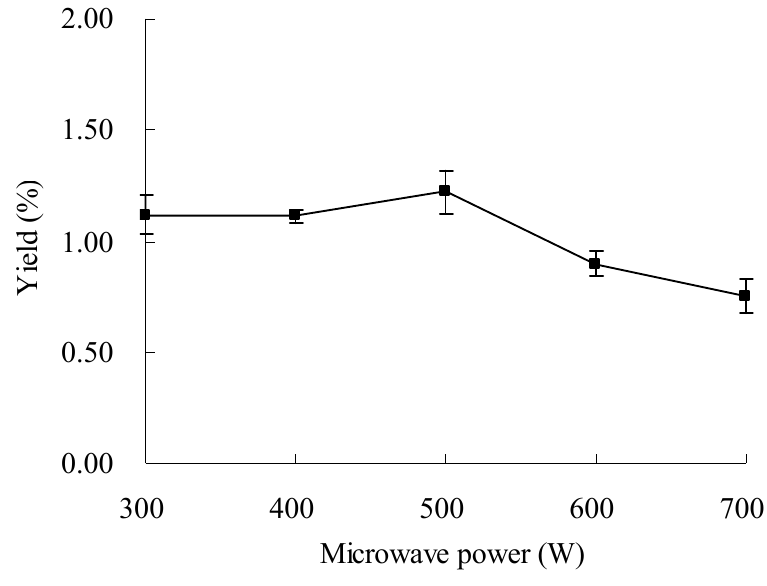
Figure 3. Effect of microwave power on the extraction